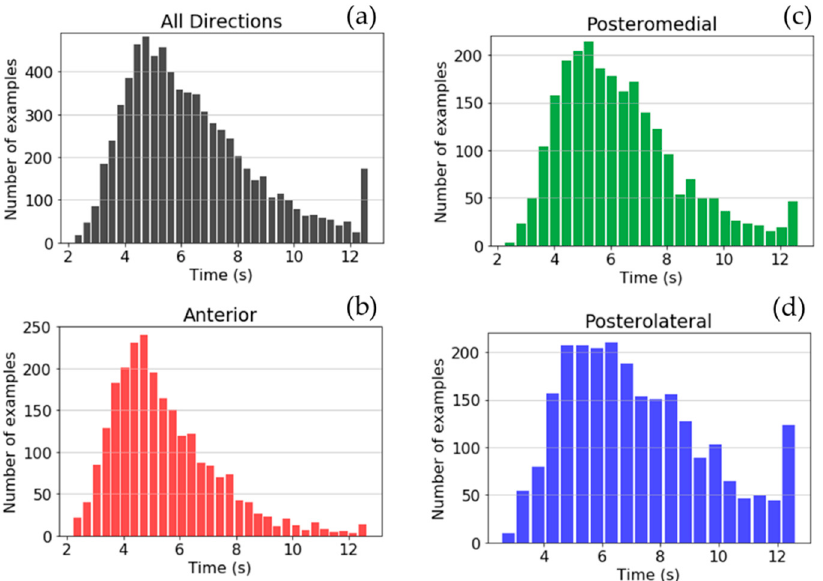
Figure 3. Histograms of YBT excursions depending on the duration for all directions: ( a ), anterior direction ( b ), posteromedial direction ( c ), and posterolateral direction ( d ).